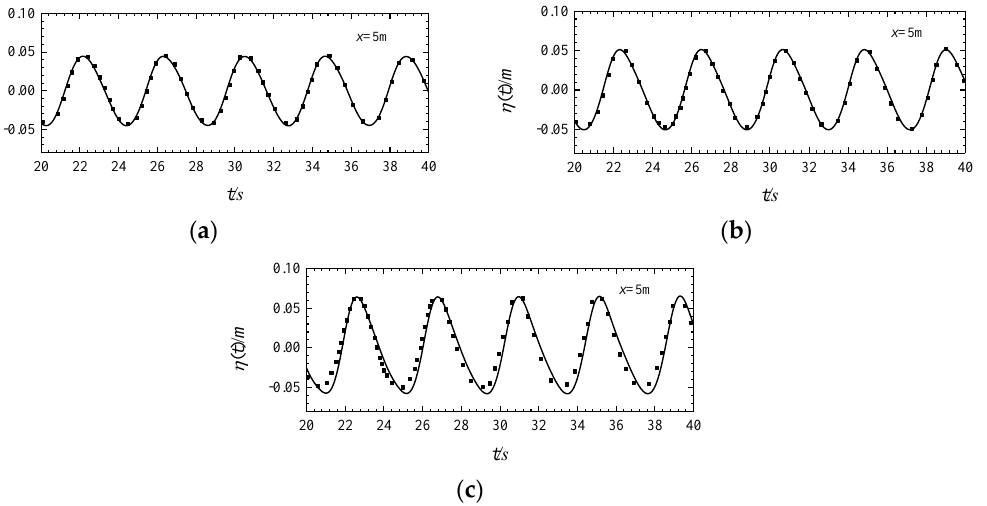
Figure 11. Wavefront ratio (at x = 5 m) of the MIKE 21 BW model (solid line) to the boundary element model ( ■ ) in downstream ( a ), no-current ( b ), counter current ( c ) environment.